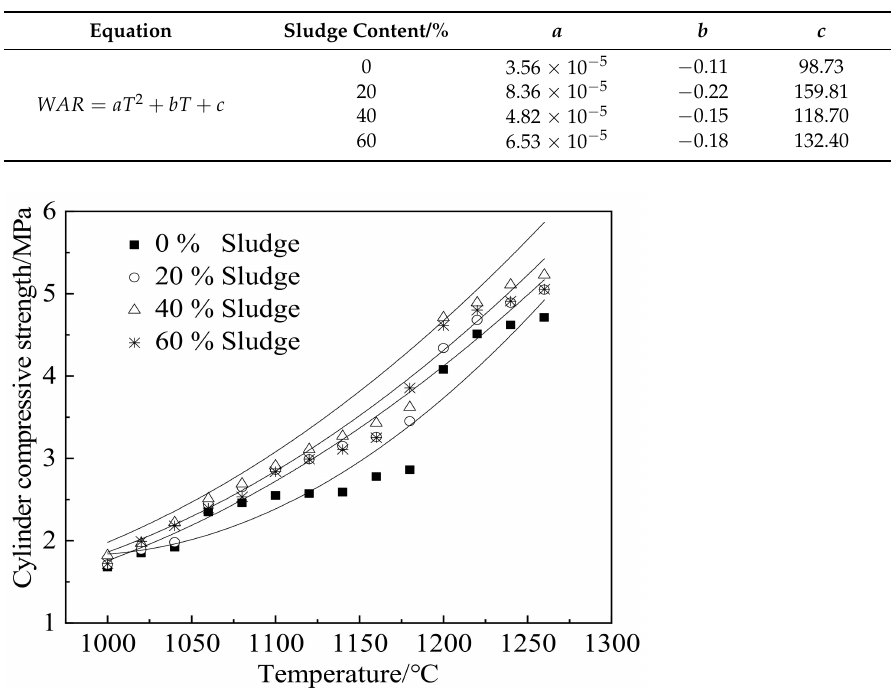
Figure 3. Water absorption rate of ceramsite. Table 3. Fitting results of the relationship between water absorption rate and temperature.